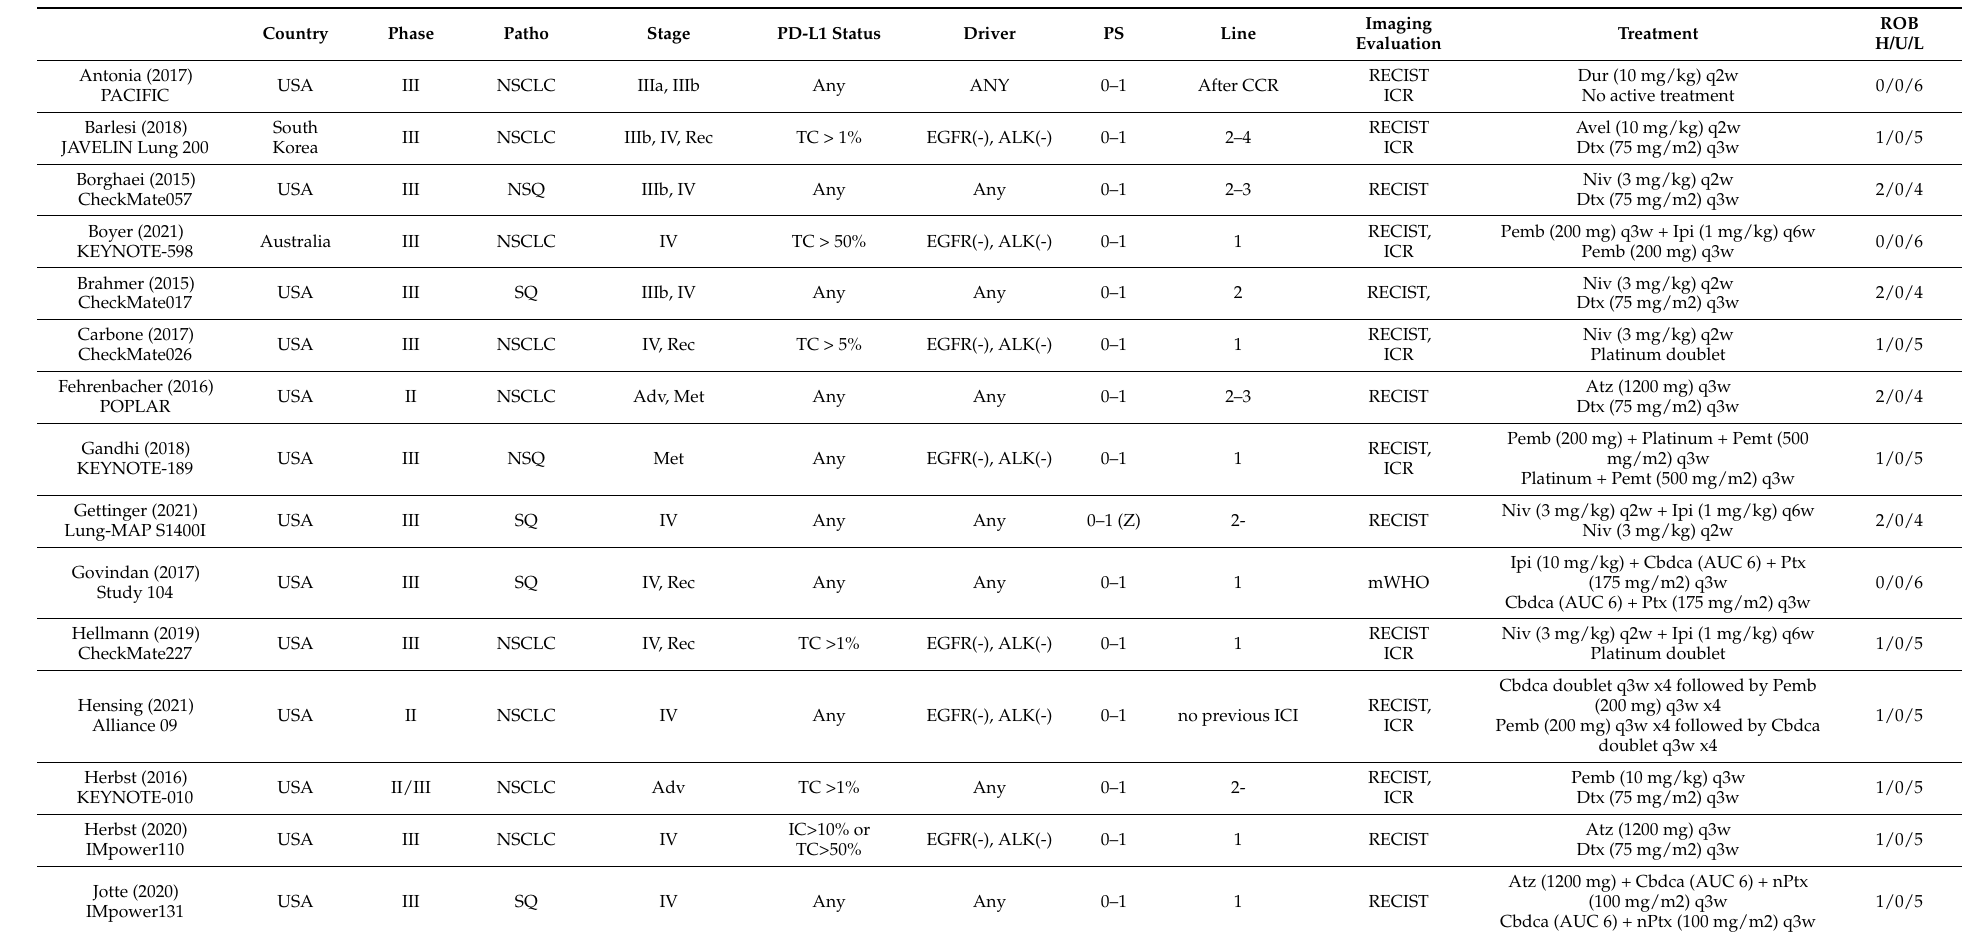
Table 2. Characteristics of trials used in the study-level